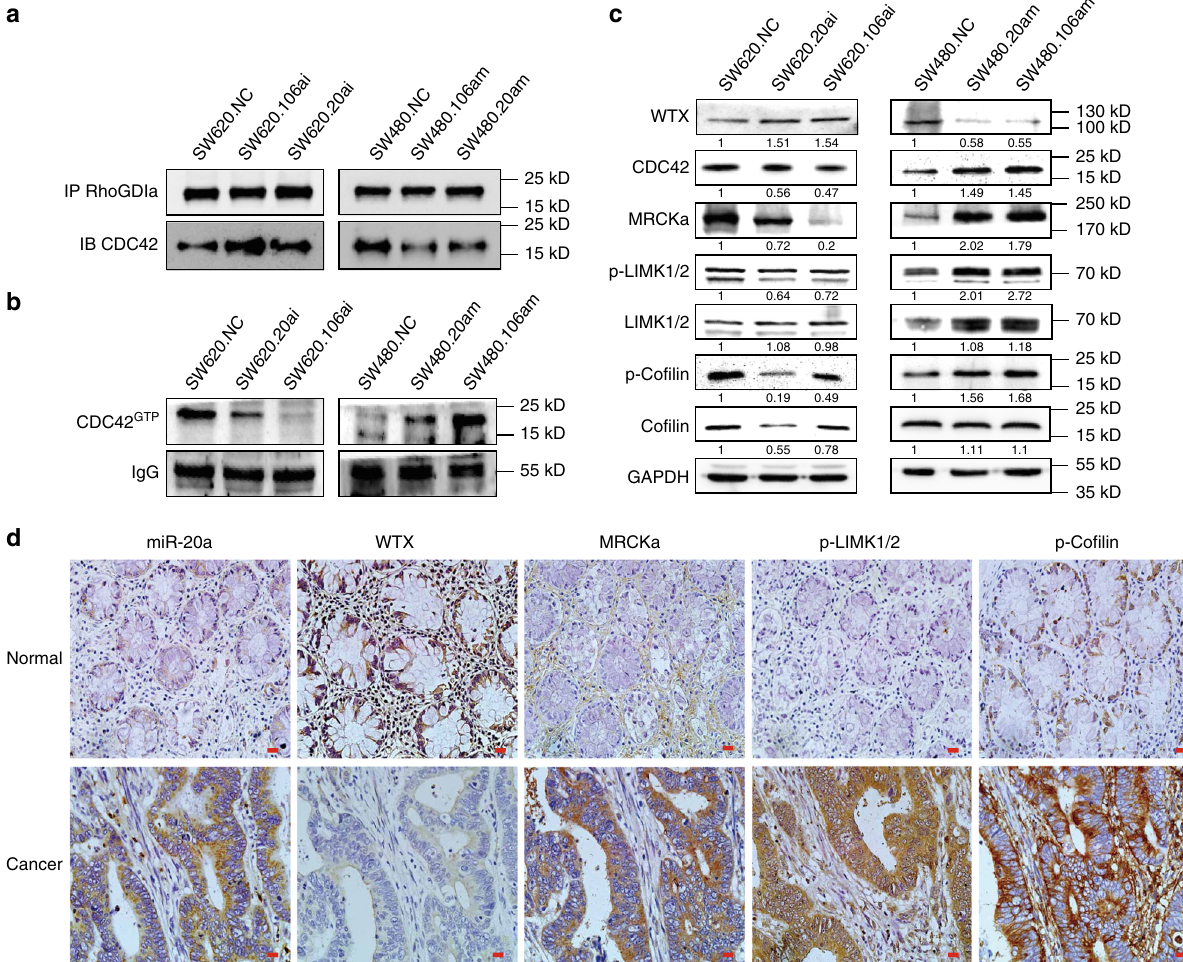
Fig. 6 Inhibiting miR-20a/106a rescued the expression of WTX and blocked CDC42 pathway and CRC progression. a CO-IP analyzes RhoGDIa binding with CDC42 in indicated cells. b IB analyzes CDC42 GTP expression in indicated cells. c IB analyzes the expressions of WTX-CDC42-MRCKa-LIMK1/2- Co fi lin axis in indicated cells. d ISH staining of miR-20a and IHC staining of WTX, MRCKa, p-LIMK1/2, and p-Co fi lin expression in CRC and matched colorectal mucosa samples. Scale bars, 20 μ